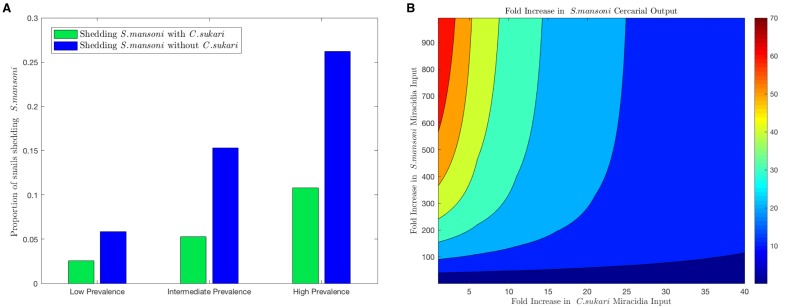
Mathematical model combining field and experimental observations.(A) At three different levels of S. mansoni prevalence in snails, the predicted reduction in prevalence of shedding snails from our transmission model due to the presence of C. sukari is estimated. In each case, the proportion of snails shedding S. mansoni is reduced by at least one half in the presence of C. sukari. (B) Relationship from model showing how S. mansoni cercariae production is maximized in this system only when the input of S. mansoni miracidia is very high relative to the input of C. sukari miracidia.